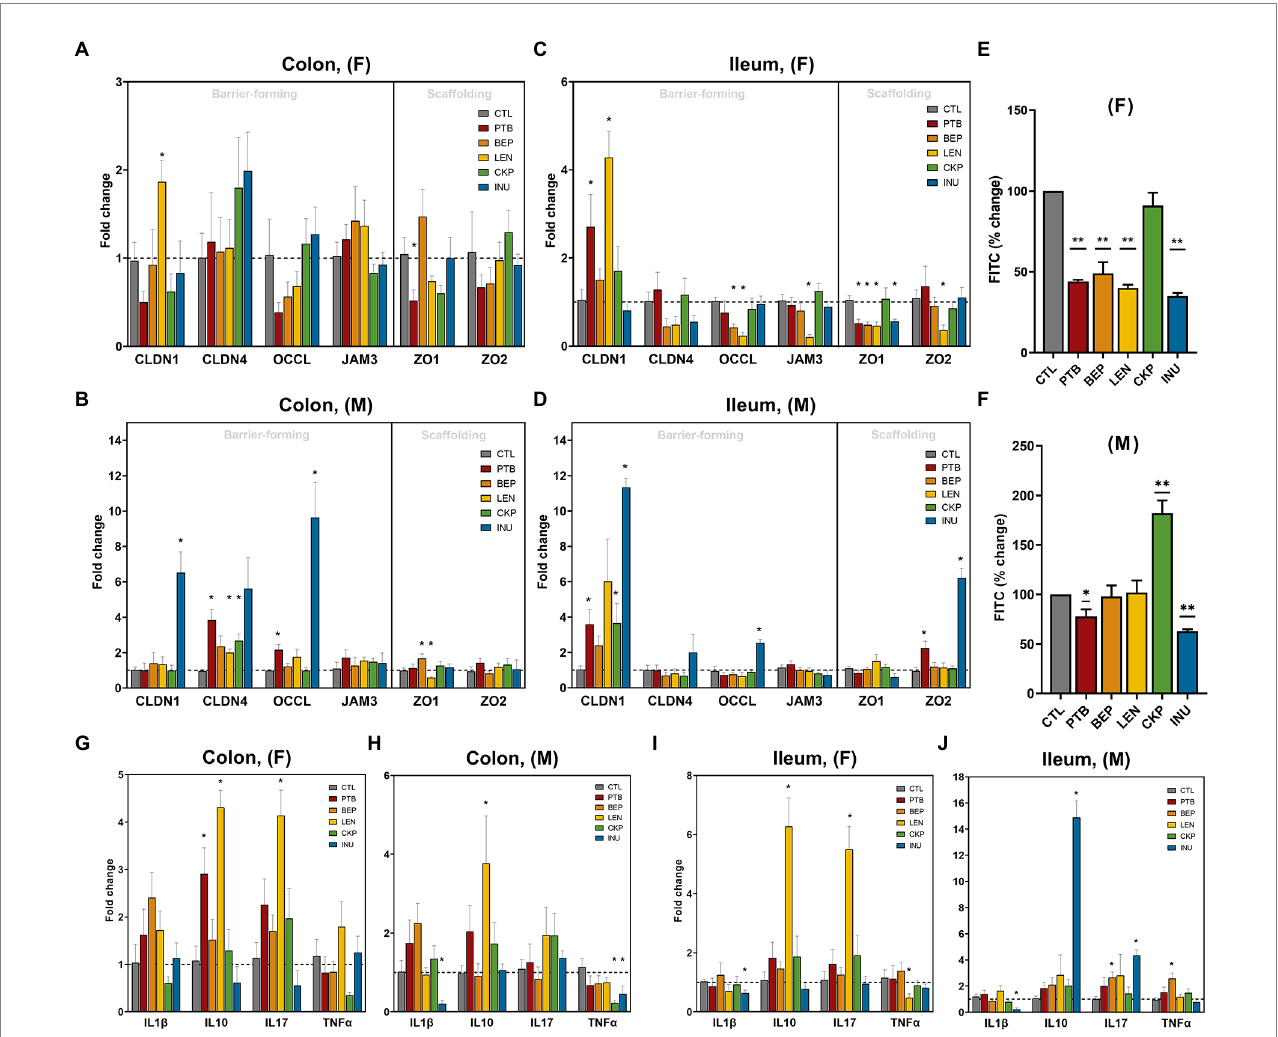
FIGURE 6 Effect of resistant starches from dietary pulses on the markers of gut permeability, intestinal integrity, and inflammation. Gene expression of tight-junction proteins viz. , claudins (CLDN-1 and CLDN-4), zonulins (ZO1- and ZO-2), occludin (OCCL), and JAM3 in (A) females’ colon, (B) males’ colon, (C) females’ ileum and (D) males’ ileum. Gut permeability (in terms of the diffusion of 4 kDa FITC dextran from gut to blood circulation) in (E) females and (F) males. Gene expression of inflammatory markers including interleukins (IL1 β , IL10, and IL17) and tumor necrosis factor-alpha (TNF α ) in (G) females’ colon, (H) males’ colon, (I) females’ ileum and (J) males’ ileum. PTB, Pinto beans; BEP, black-eyed peas; LEN, Lentils; CKP, chickpeas; INU, inulin; CTL, control high-fat diet group. * p < 0.05, ** p <